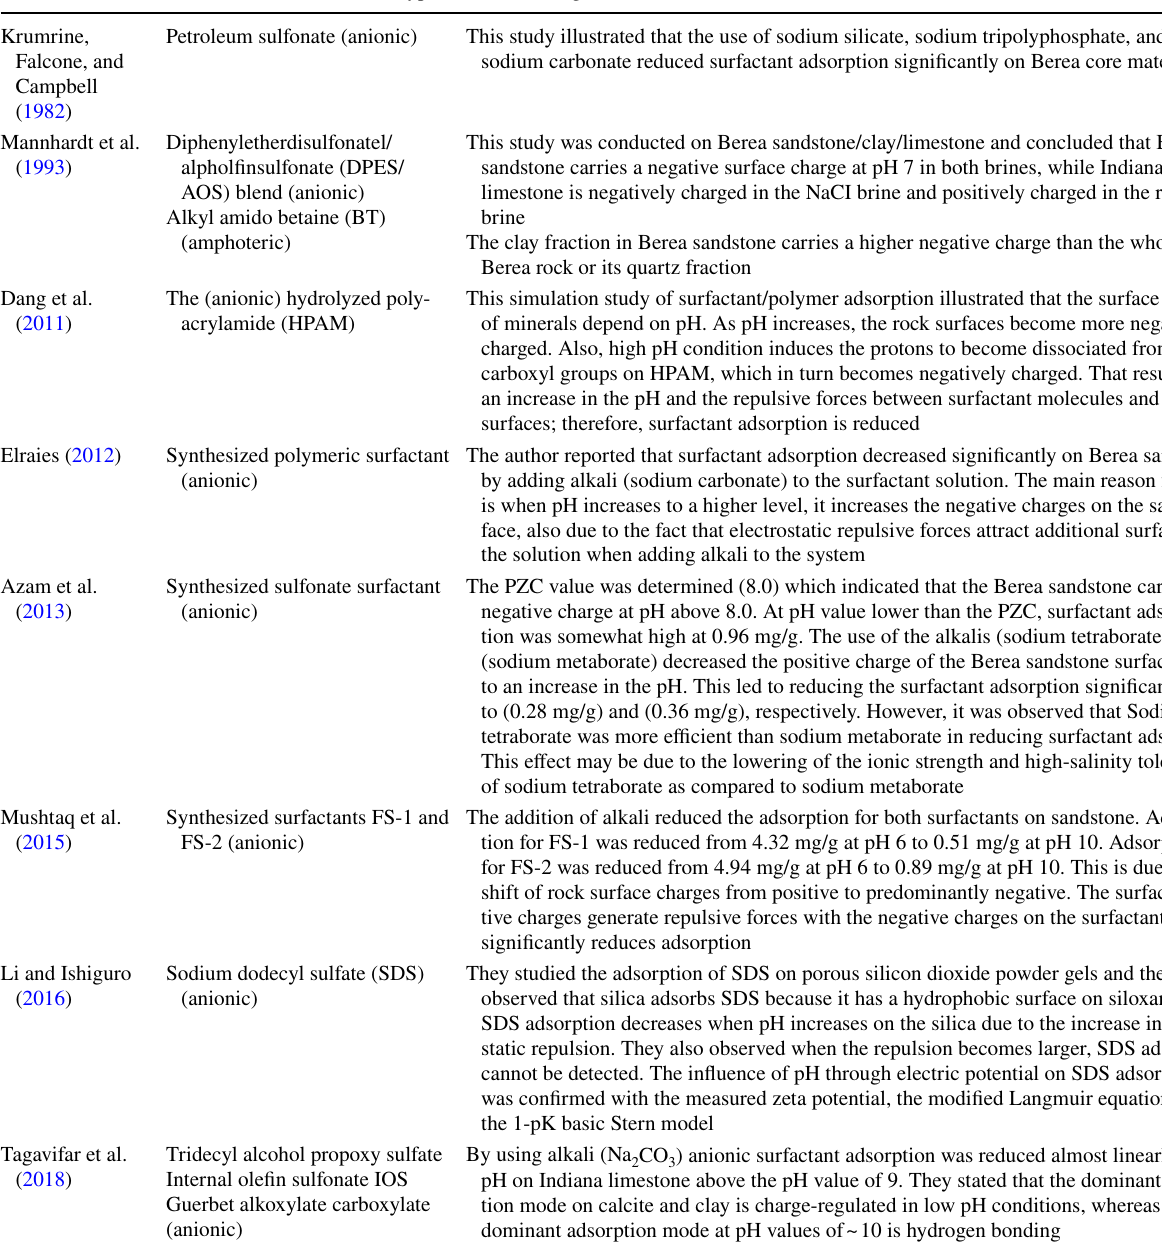
Table 3 Summary of several studies highlighting the effect of pH on surfactant